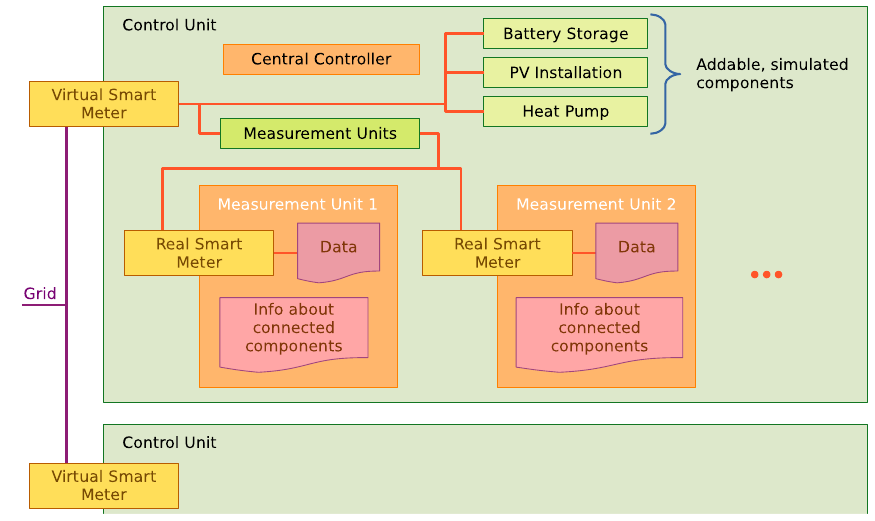
Fig. 2 Concept of a virtual smart meter: Distinction of measurement units as smart meter data input and control units that combine all smart meters in one house and potentially add simulated components. Red lines depict control unit internal energy flows. Crimson lines represent the local energy system